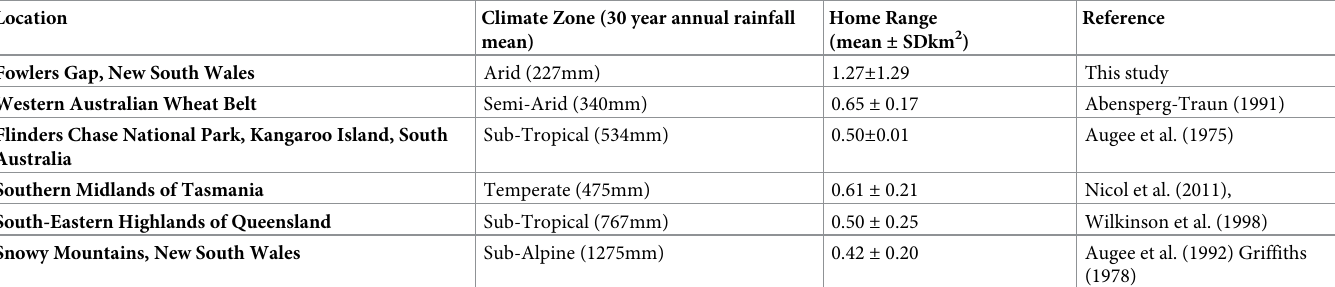
Table 3. Comparison of the home range size of echidnas within different climate